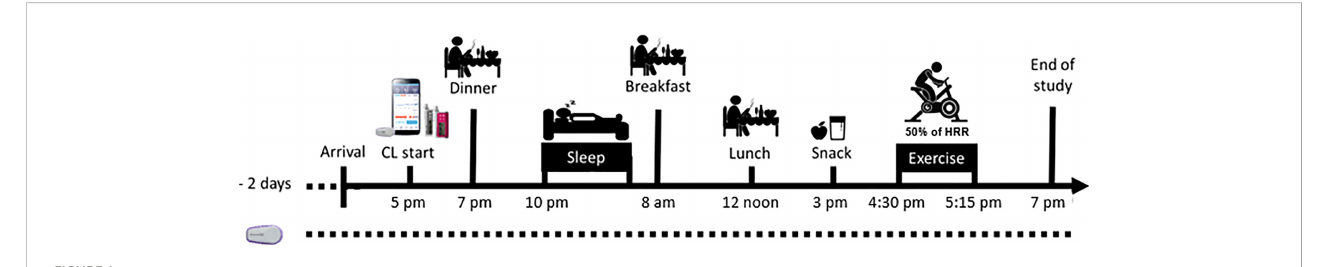
FIGURE 1 Schematic overview of the study